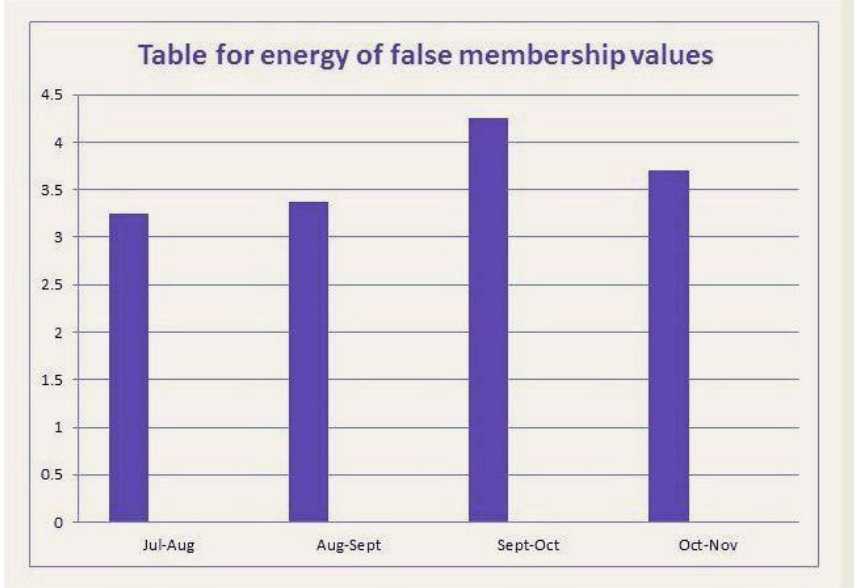
Figure 18. Energy of false membership